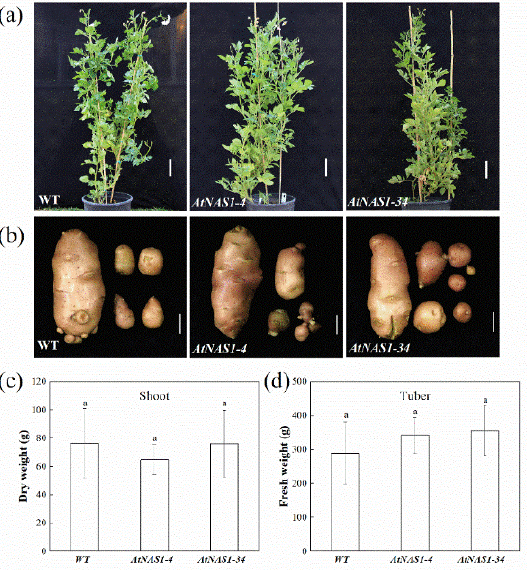
Figure 2. Phenotype of AtNAS1 -overexpressing potato and WT plants grown in a greenhouse. ( a ) Images of transgenic potato grown in soil. ( b ) Tubers of transgenic and WT potato. Shoot dry weight ( c ) and tuber fresh weight ( d ) of transgenic and WT potato. The data represent means from three biological replicates. a in the picture represents significant difference. Error bars = SD. Student’s t -test was used to examine statistical significance, p < 0.05.